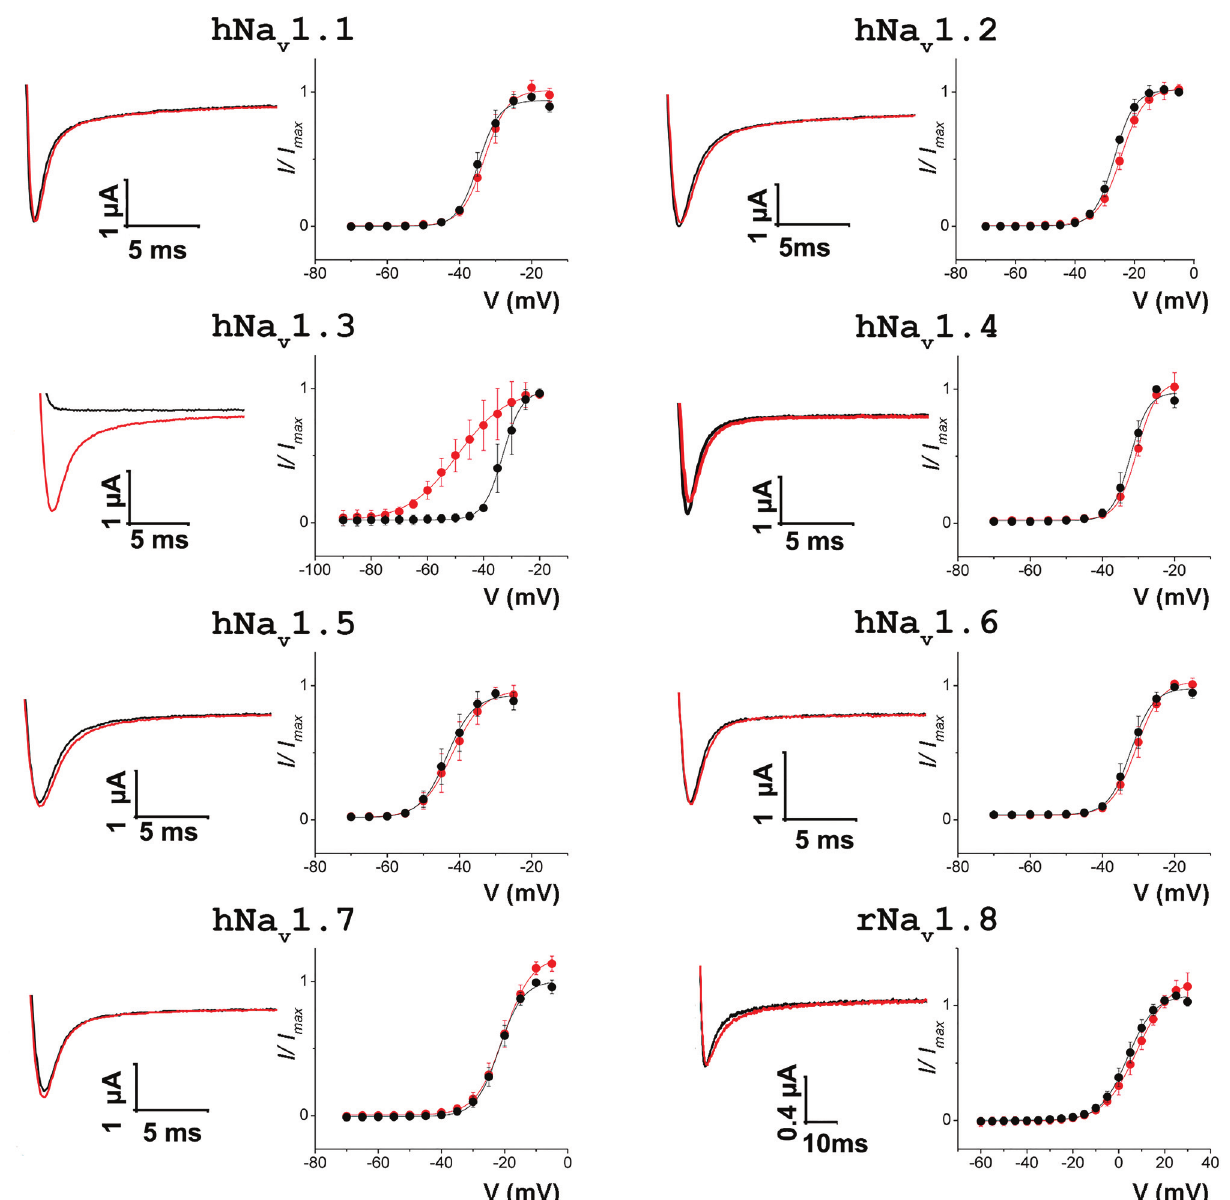
Fig 4. Effect of Tf2 on Na v channel isoforms expressed in X . laevis oocytes. Shown on the left in each column is a representative trace of experimental Na + currents obtained by depolarizing the membrane to a suitable voltage from a holding potential of -90mV, at -25mV for Na v 1.1 – 1.2, 1.4 – 1.7, at -40mV for Na v 1.3, and at 20mV for Na v 1.8. Shown on the right in each column is a deduced conductance (G) — voltage (V) relationship before (black) and after (red) the application of 1 μ M Tf2. This concentration only influences the activation of hNa v 1.3. Data is shown as mean ± SEM of n >